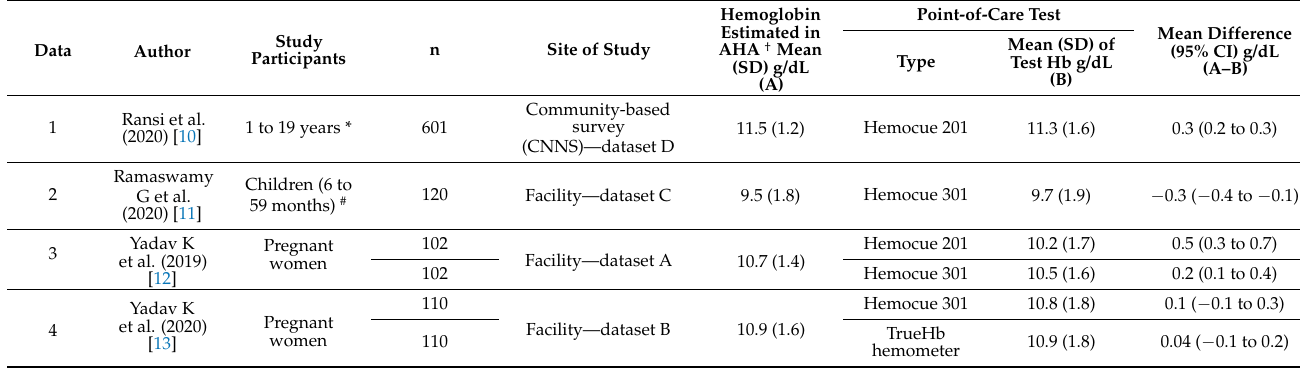
Table 1. Overview of hemoglobin estimated in the automated hematology analyzers (reference or gold standard) and digital hemoglobinometers in the studies included in the calculation of correction factor.